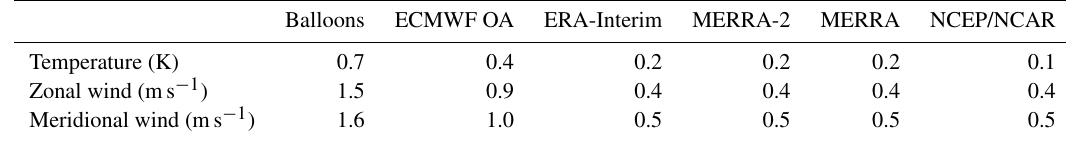
Table 4. Standard deviations of high-pass-filtered meteorological analyses and Concordiasi balloon observations.